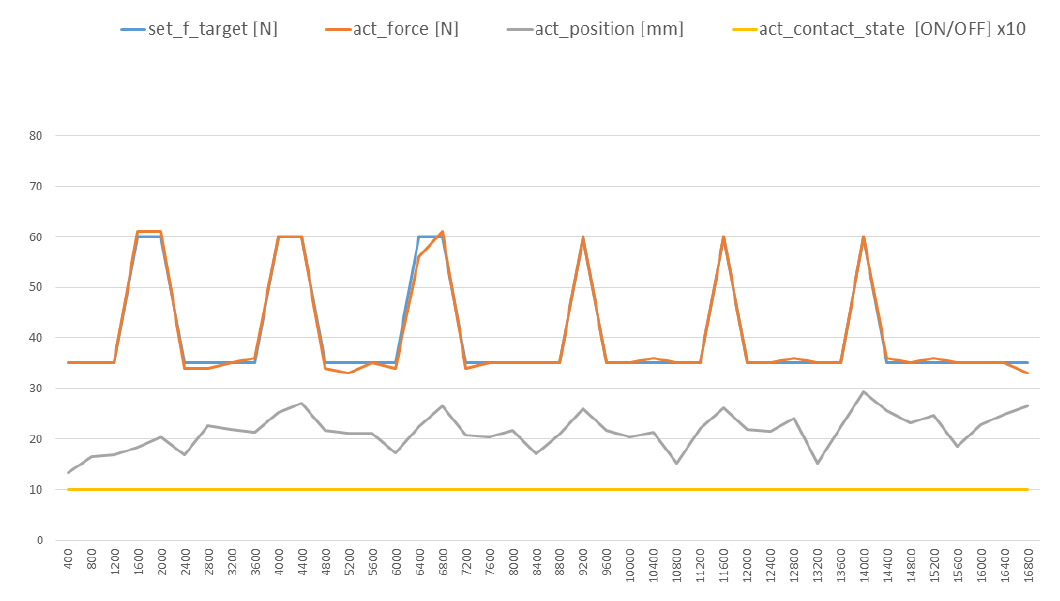
Figure 12. Visual inspection using the three proposed computer vision algorithms. The histograms in Figure 13b are used to check when the material color has reached a threshold. This is used to check if grinding is required or no longer required at different regions on the fan blade.